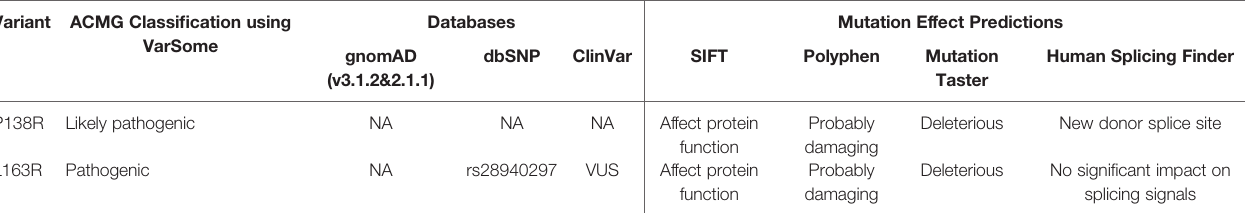
TABLE 1 | Databases and online predictions for our pVHL